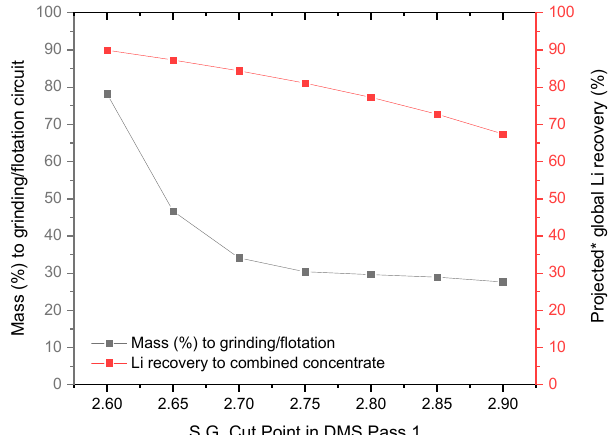
Figure 11. The effect of S.G. cut point in DMS Pass 1 on mass recovery and global lithium recovery (combined DMS and flotation).